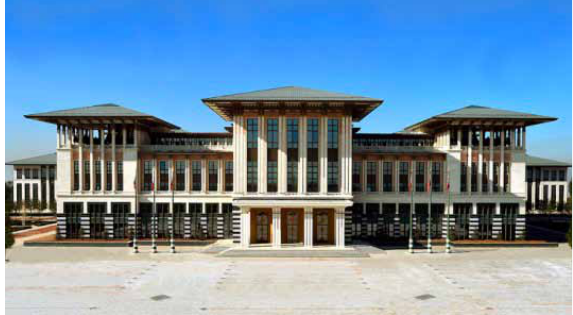
fig. 4. White Palace of post-2000s period, by Birkiye (arkitera